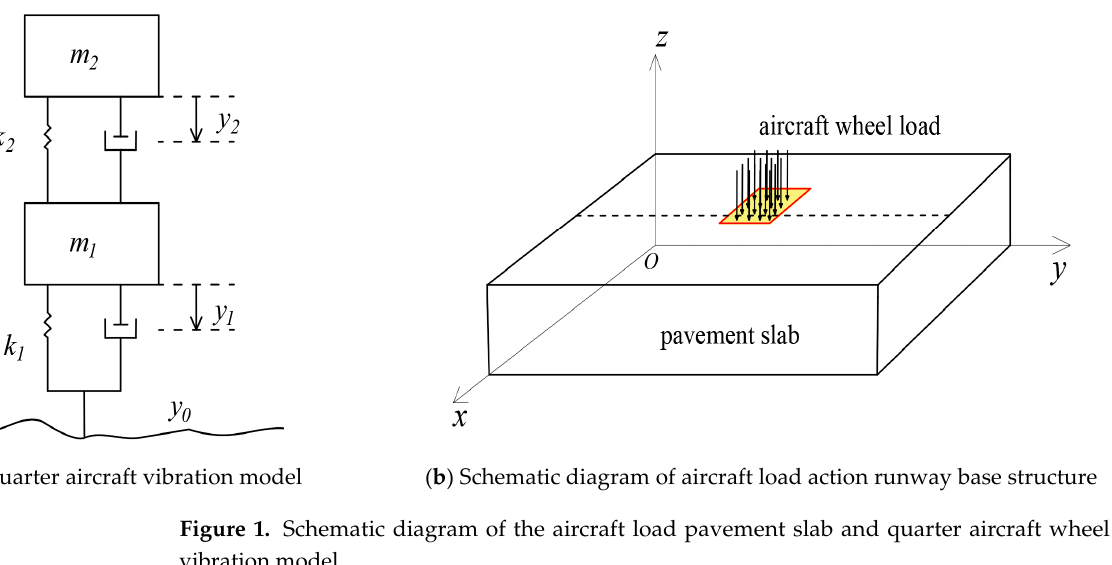
Figure 1. Schematic diagram of the aircraft load pavement slab and quarter aircraft wheel load vibration model.